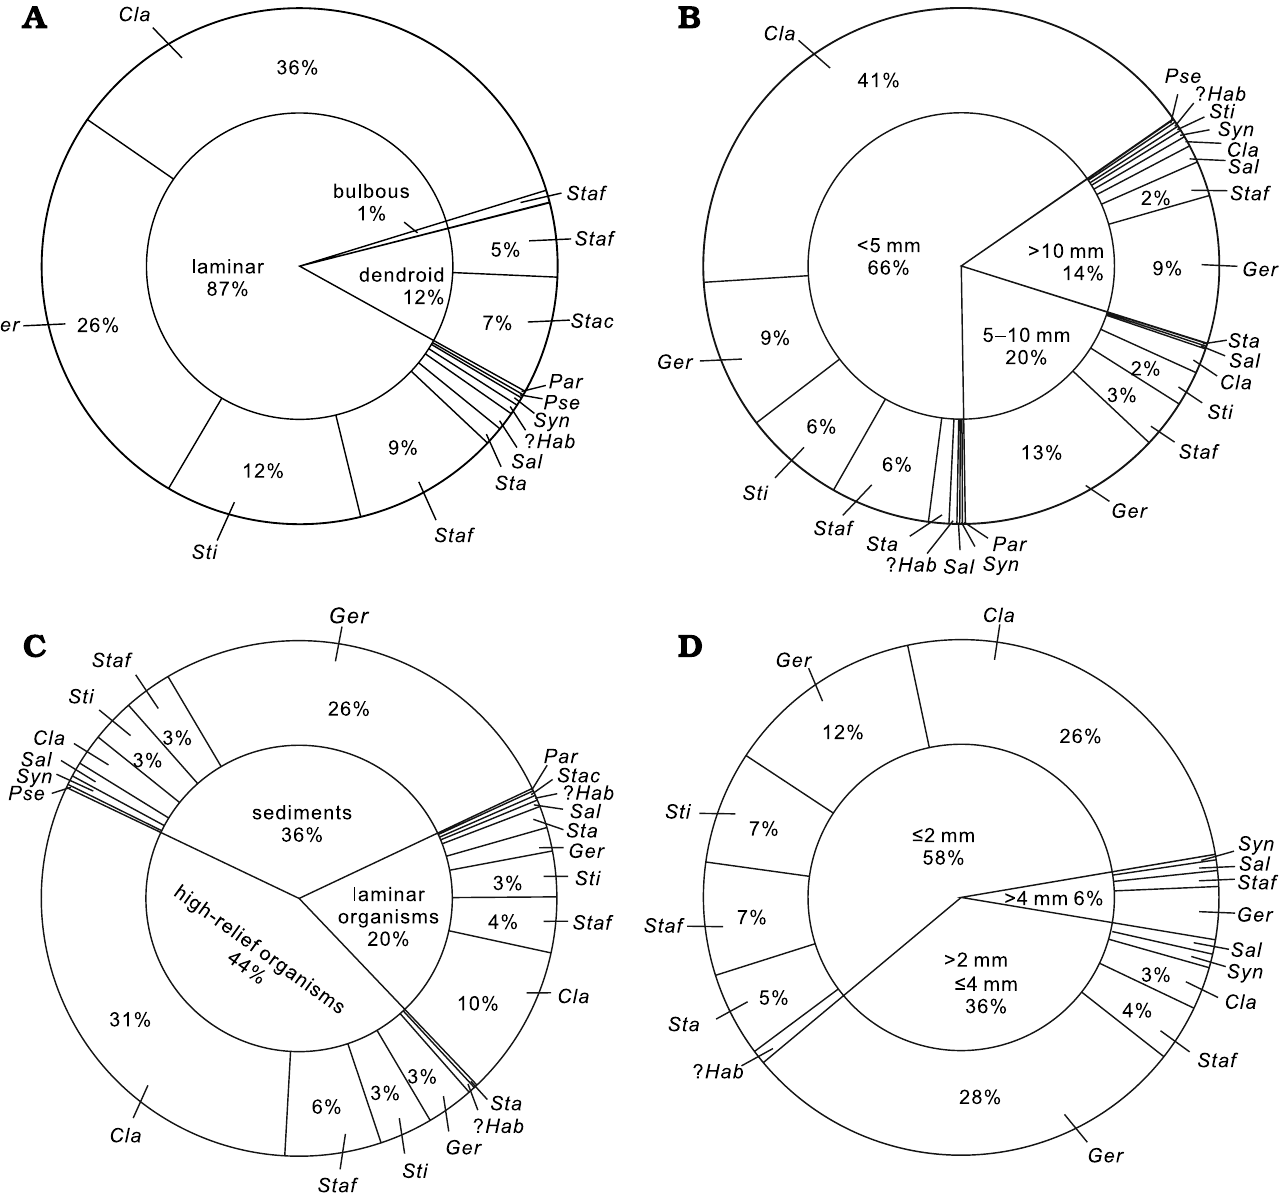
Fig. 4. Pie charts illustrating palaeoecological parameters of the stromatoporiod fauna. A . External morphology. B . Thickness. C . Substrate types. D . Thickness of growth interruption. Abbreviations: Ger , Gerronostromaria grossum Dong, 1974; Cla , Clathrocoilona spissa (Lecompte, 1951); ? Hab , ? Habrostroma laminosum (Lecompte, 1952); Par , Parallelopora sp.; Pse , Pseudotrupetostroma porosum (Yang and Dong, 1979); Sal , Salairella buec­ heliensis (Bargatzky, 1881); Sta , Stachyodes sp . ; Stac , Stachyodes costulata Lecompte, 1952; Staf , Stachyodes fasciculata Dong in Dong et al., 1989; Sti , Stictostroma saginatum (Lecompte, 1951); Syn , Synthetostroma actinostromoides Lecompte,